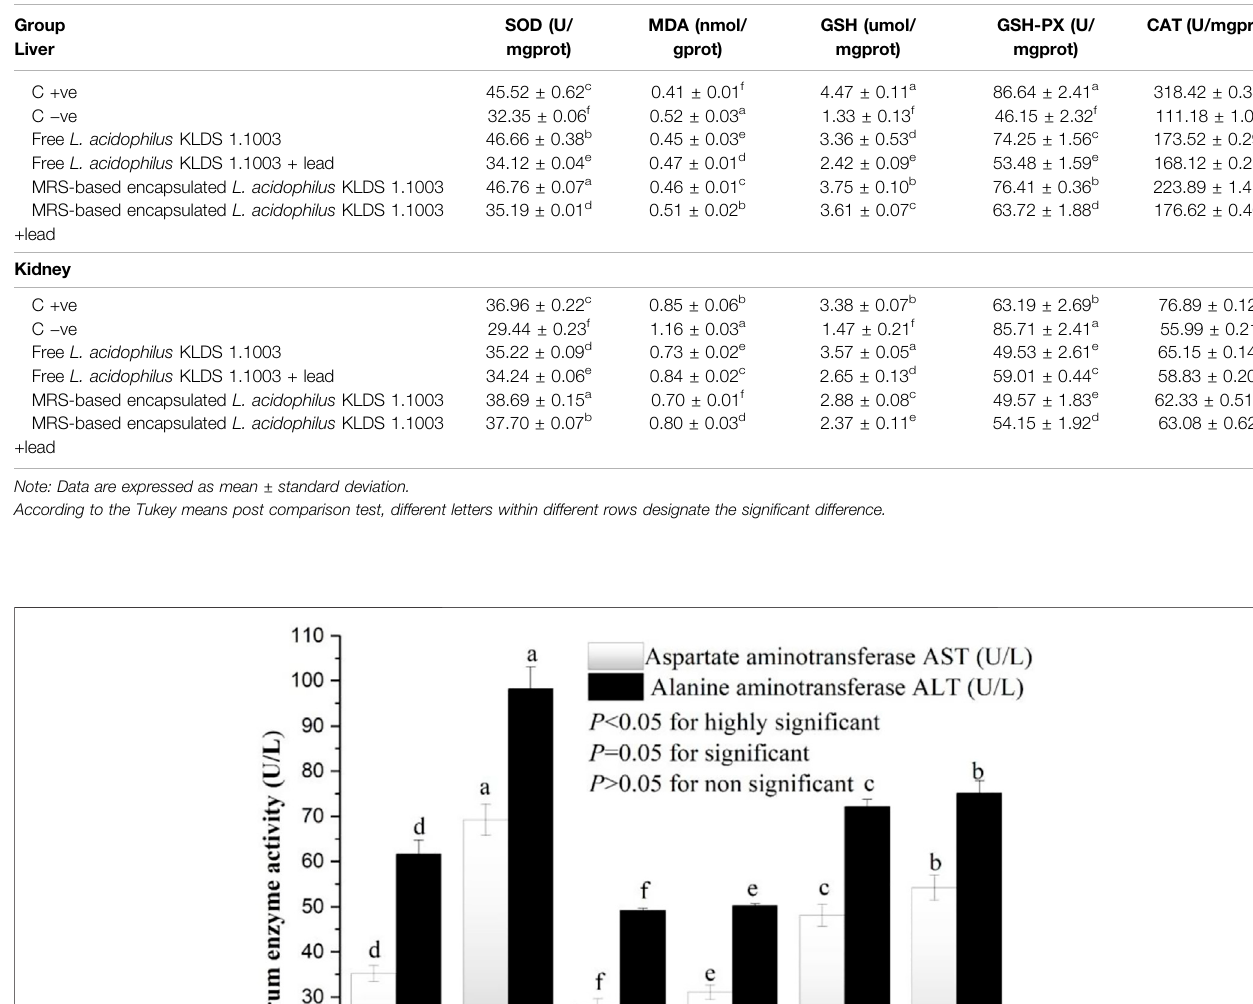
Frontiers in Bioengineering and Biotechnology |